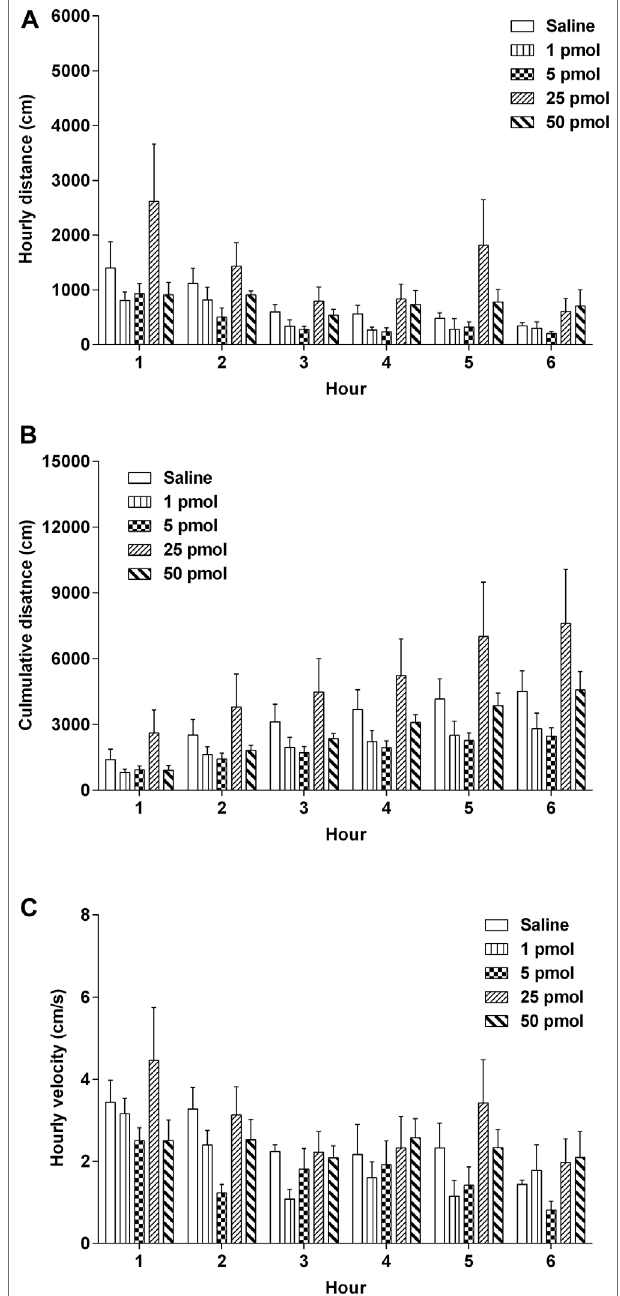
FIGURE 8 | Effects of intracerebral drug administration on locomotor activity in Suncus murinus . (A) Hourly distance travelled, (B) cumulative distancetravelled,and (C) hourlyvelocityfrom0 – 6 hani.c.v.administrationof saline (5 μ l, i.c.v.) or nesfatin-1 (1 – 50 pmol, i.c.v.). The results represent the mean± s.e.m. of5 – 7determinations during aperiod of6 h. Nosigni fi cant differences between the treatment groups are observed (one-way ANOVA or two-way ANOVA, followed by Bonferroni